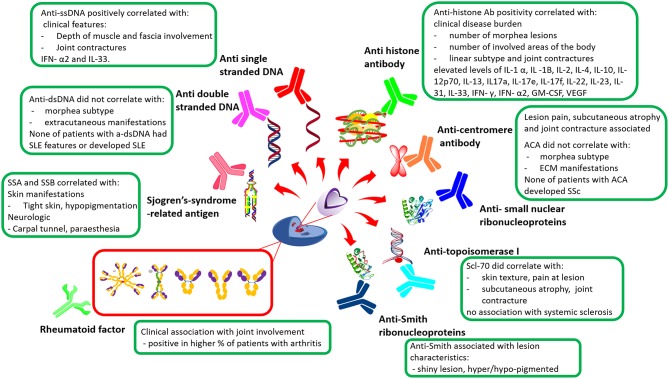
General overview of morphea autoantibodies in relation to clinical features. Anti-ssDNA, Anti-single stranded DNA; IFNx, Interferon; ILx, Interleukin; SSA, Sjogren's-syndrome-related antigen A; SSB, Sjogren's-syndrome-related antigen B; Scl-70, Topoisomerase I; ACA, Anti-centromere antibody; ECM, Extracutaneous manifestations; SSc, Systemic Sclerosis; SLE, Systemic lupus erythematosus; GM-CSF, Granulocyte-macrophage colony-stimulating factor; VEGF, Vascular endothelial growth factor; Ab, Antibody (9, 10, 13, 18, 19, 27–30, 37, 38).